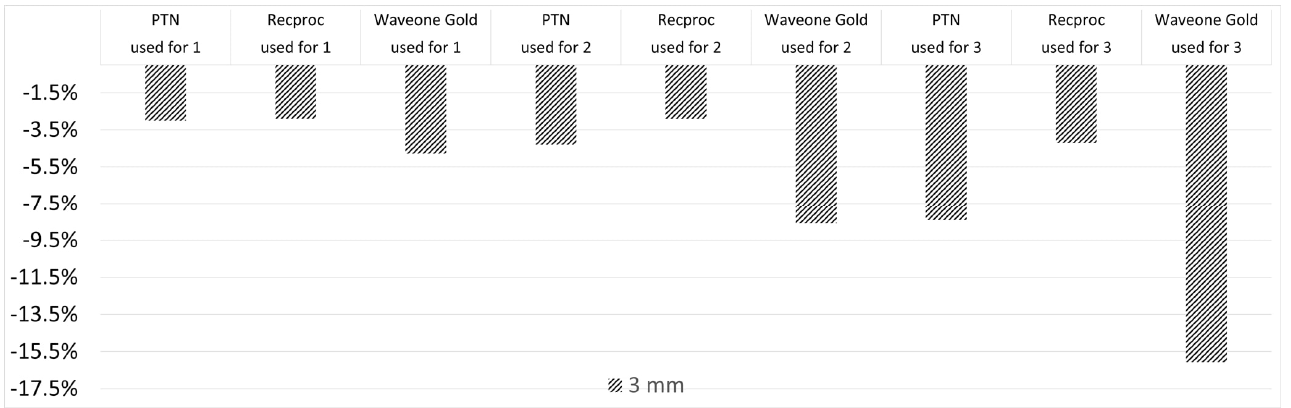
Figure 3. Comparison of the average wear values of the files were measured at 3rd millimeter from the apical compared to the file that was never used between different file systems.